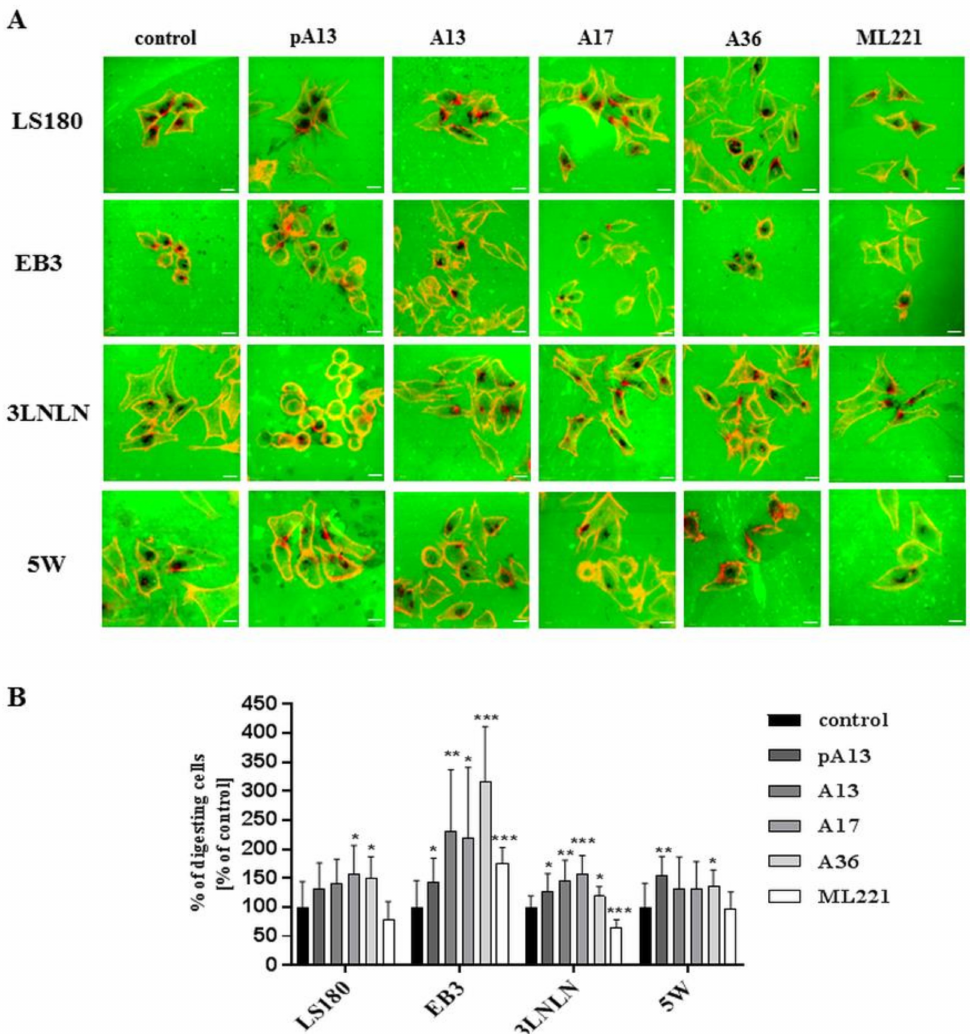
Figure 4. Influence of apelin on proteolytic activity of colon cancer cells. ( A ) The proteolytic activity of colon cancer cells (red) after apelin peptides (100 nM) or ML221 (100 nM) stimulation using FITC-conjugated gelatine (green). Scale bars represent 10 µ m; ( B ) The number of cells digesting gelatine was expressed as a percent of digesting cells and results are shown as a percent of control. Results are expressed as the mean (percent of digesting cells) ± SD of three independent experiments. p ≤ 0.05 (*), p ≤ 0.01 (**), p ≤ 0.001